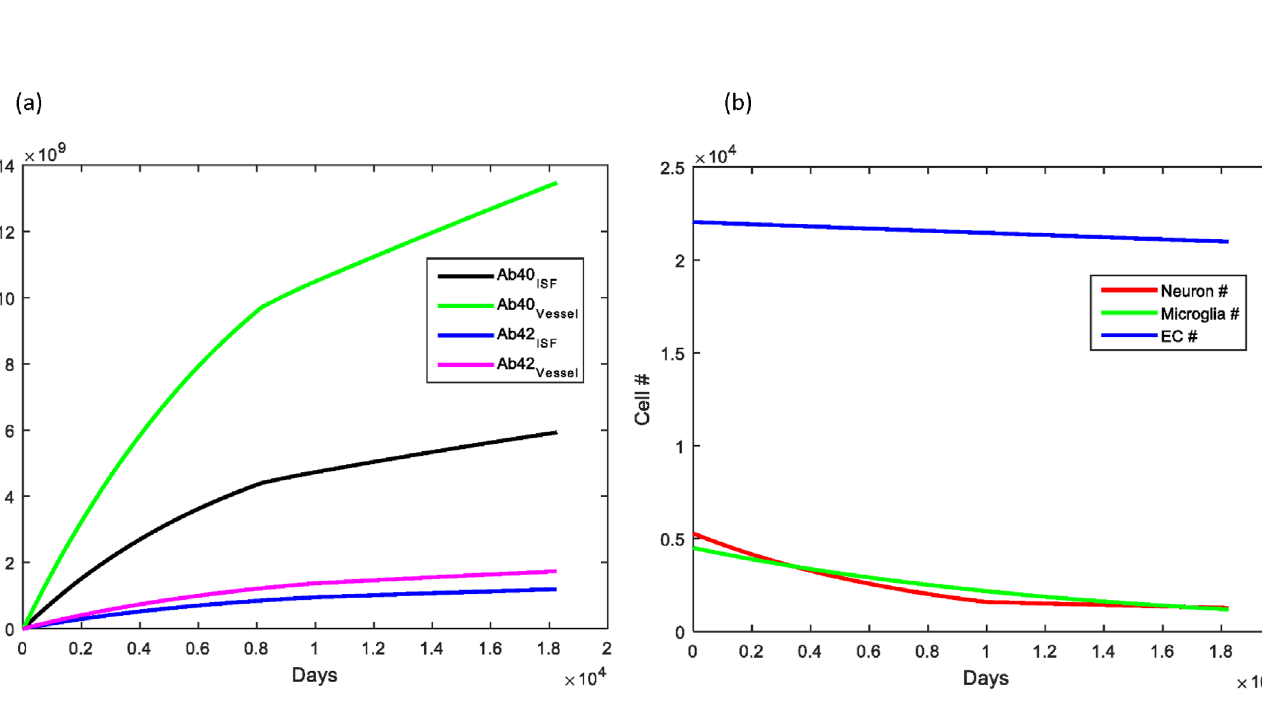
Fig 6. Effect of ApoE allele on A β clearance and deposition. (A) Levels of A β 40 deposition in cerebral vessels increased nearly two-fold with only a 67% increase in A β 42 deposition there. No changes from baseline simulations were noted in A β levels in the brain parenchyma. (B) No changes in cell number were observed compared to baseline values for